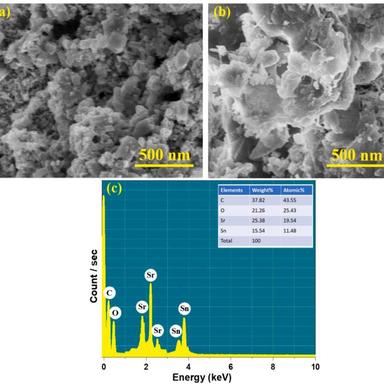
SEM of (a) SrSnO3, (b) SrSnO3/rGO nanohybrid and (c) EDX of SrSnO3/rGO nanohybrid.